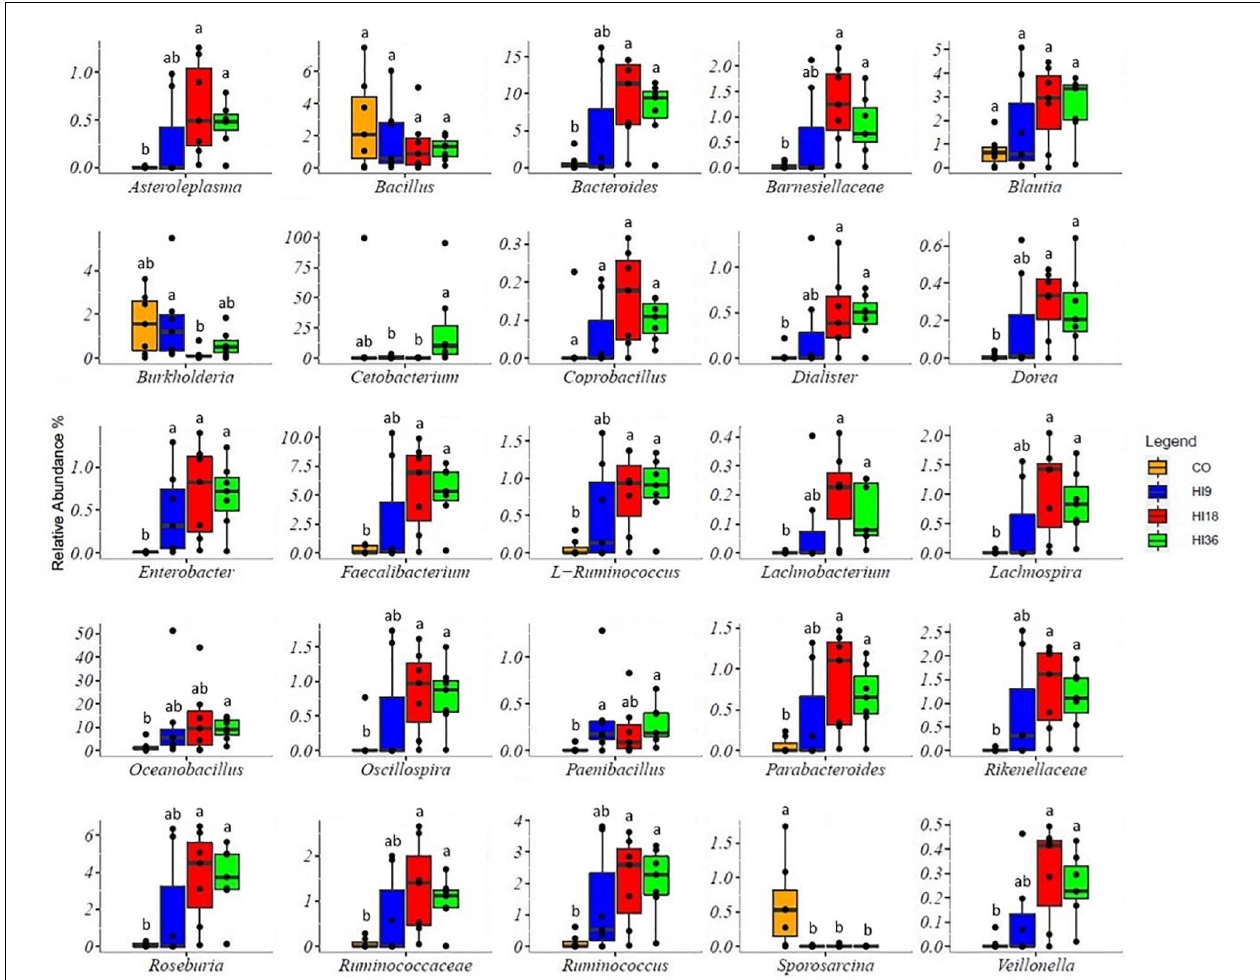
FIGURE 6 | Boxplots showing the relative abundance at the genus level of the OTUs in the intestine of perch fed experimental diets. Means with different letters are significantly different (FDR < 0.05) from each